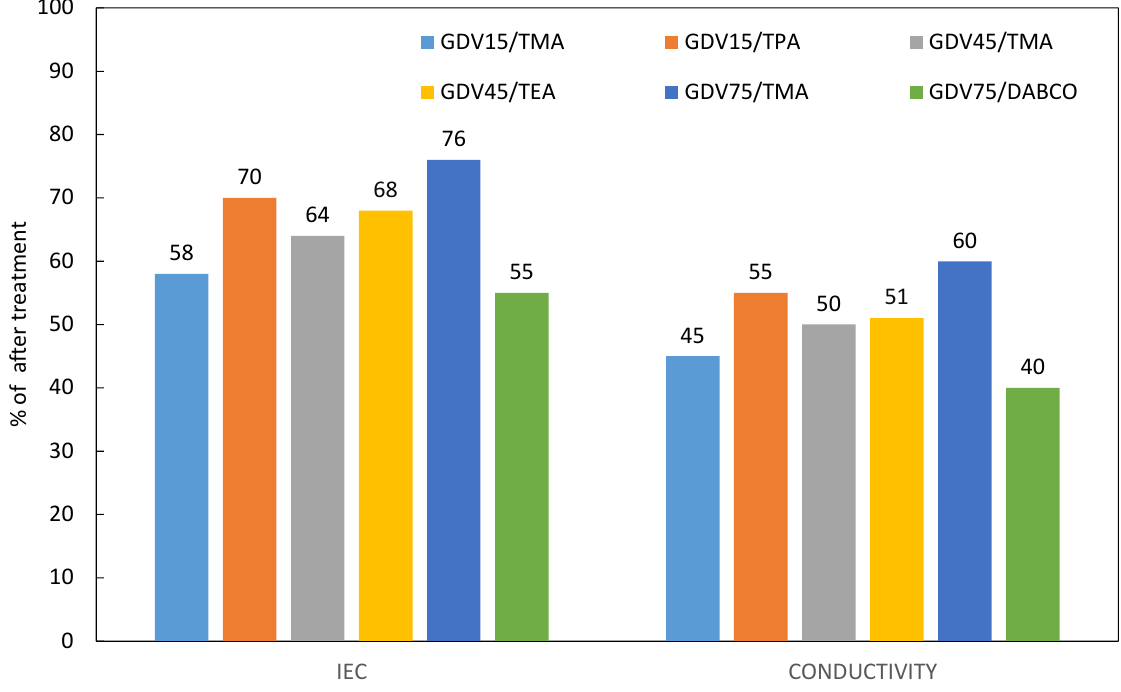
Figure 8. Changes in IEC and conductivity of the select membranes with alkaline stability test at 60 °C for 144